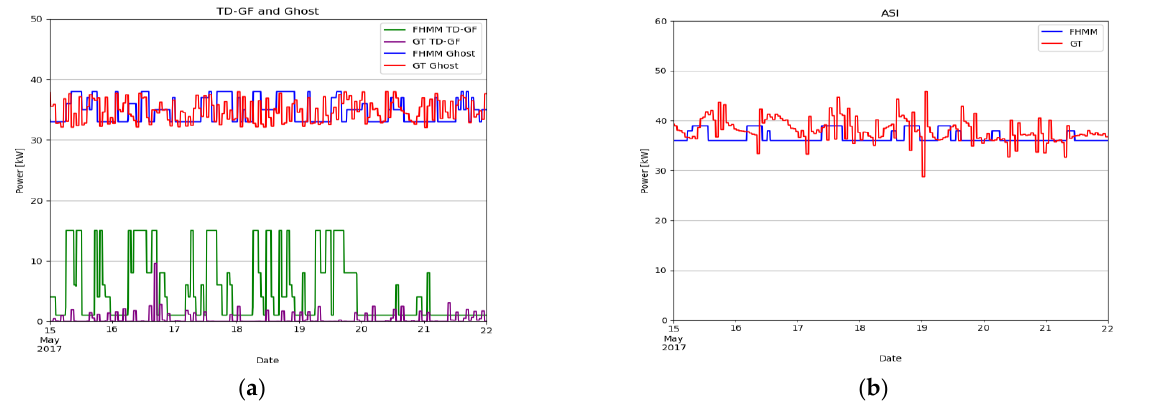
Figure 13. Disaggregation results following the application of the FHMM algorithm for the TD-GF, Ghost and ASI loads, ( a ) TD-GF and Ghost, ( b ) ASI.